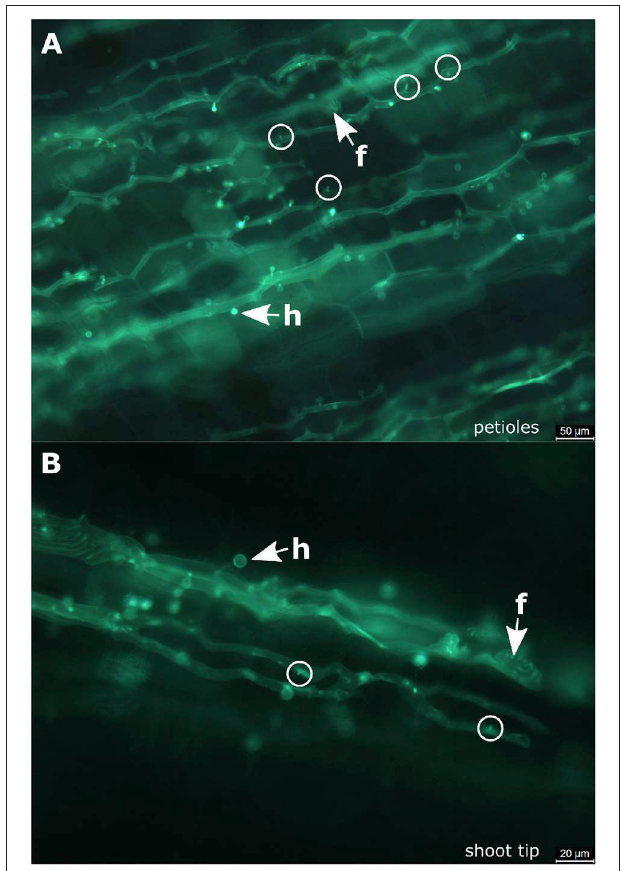
FIGURE 3 | Infected petioles and shoot tips. (A) Microscopic image of an infected petiole from “Pinot blanc.” The hyphae follow the elongated structure of the organ and form numerous haustoria. At some positions, it is possible to observe the beginning of haustoria formation starting from small pegs (circle). (B) Microscopic picture of an infected shoot tip. Besides a longitudinal course of the regular hyphae, the fan-shaped hyphae are observed. The initial stages of haustoria formation are high-lighted by circles. f, fan-shaped hyphae; h, haustoria; circle, penetration peg.